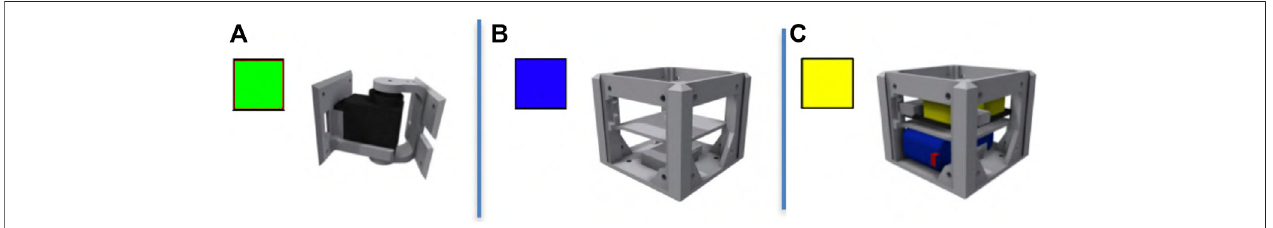
FIGURE1| Modulesofrobots:Theactivehingecomponent (A) isajointmovedbyaservomotor withattachmentslotsonbothends;Thebrickcomponent (B) isa smaller cube with attachment slots on its lateral sides; The core component (C) is a larger brick component that holds a controller board and a battery.